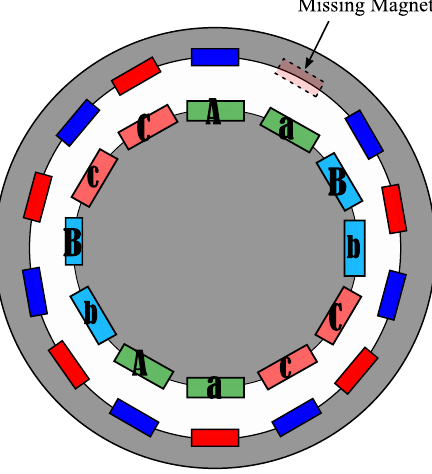
Figure 6. Representation of the used motor with a missing